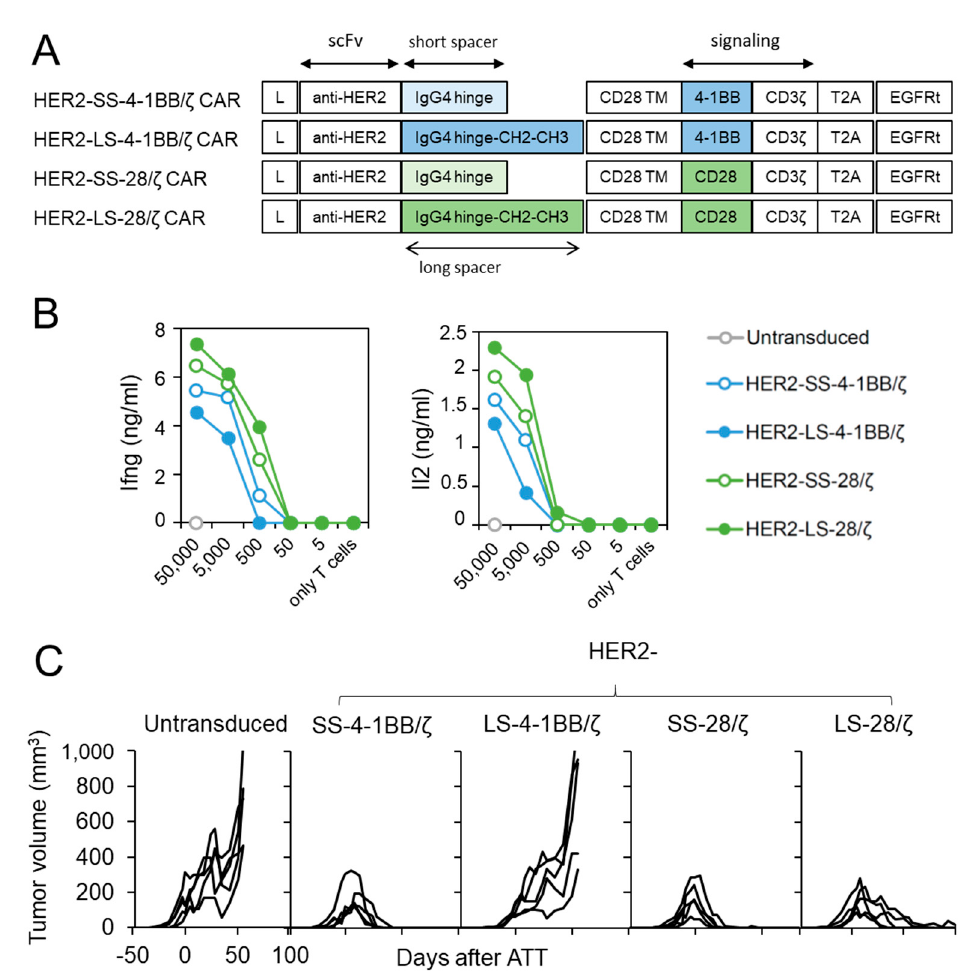
Figure 4. HER2-specific CAR T cells with CD28 signaling outperform 4-1BB harboring CAR T cells. ( A ) Scheme of retroviral CAR T cell constructs used to generate HER2-specific second-generation CAR T cells harboring a short or long spacer with 4-1BB or CD28 signaling domain. L: leader sequence; TM: transmembrane domain; T2A: virus 2A self-cleaving sequence, EGFRt, truncated epidermal growth factor receptor. ( B ) CD8 + T cells derived from ChRLuc/OT-1/Rag − / − transduced with indicated CAR constructs were co-cultured with titrated numbers of SKOV3 target cells for 24 h. Levels of secreted cytokines were measured by Ifng and Il2 ELISA. Shown is one representative experiment of three. ( C ) Rag − / − mice were subcutaneously injected with SKOV3 tumor cells and treated with 1 × 10 6 CAR T cells equipped with the indicated HER2-specific CAR constructs or with untransduced T cells ( n = 5 for each treatment group). Tumor volume was determined by caliper measurement. A single experiment is shown with each line representing change in tumor volume of an individual mouse over time.